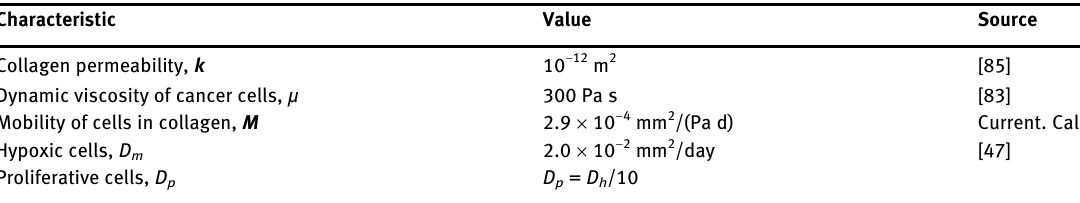
Table  : Mobility and random motility of Glioma Cells.